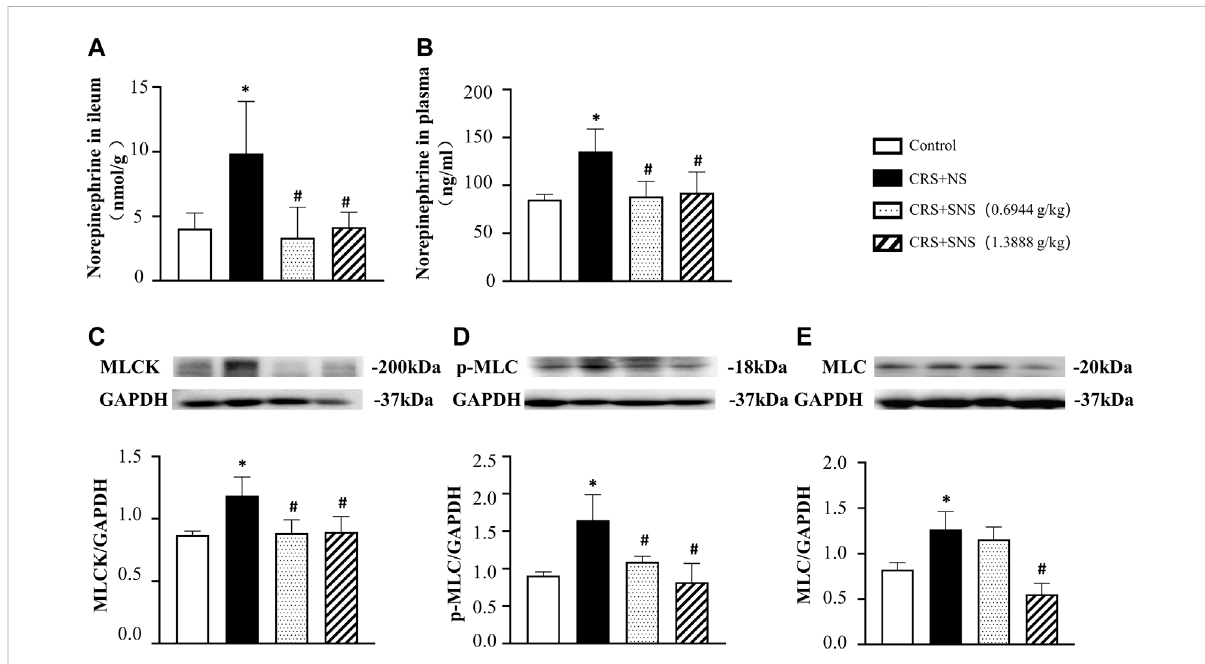
FIGURE 3 Effect of the SNS treatment on the level of NE in the ileum tissue and plasma and the expression of MLCK, p-MLC, and MLC in the colon tissue. (A) NEconcentrationintheileumtissuefromdifferentgroups.F=6.027. p =0.0060. (B) NEconcentrationinplasmafromdifferentgroups.F=6.458. p =0.0075. (C) WesternblotofMLCKinthecolontissuefromdifferentgroupswithquanti fi cationshowingbelow.F=6.947. p =0.0058. (D) Western blot of p-MLC in colon tissue from different groups with quanti fi cation showing below. F = 10.83. p = 0.0010. (E) Western blot of MLC in colon tissue from different groups with quanti fi cation showing below. F = 17.71. p = 0.0001. Results are presented as mean ± SEM. * p < 0.05 vs. Control group; # p < 0.05 vs. CRS + NS group. (A) n = 5. (B – E) n =